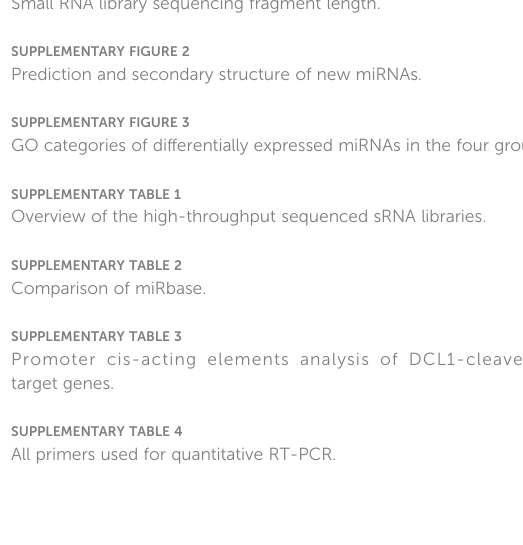
Small RNA library sequencing fragment length.